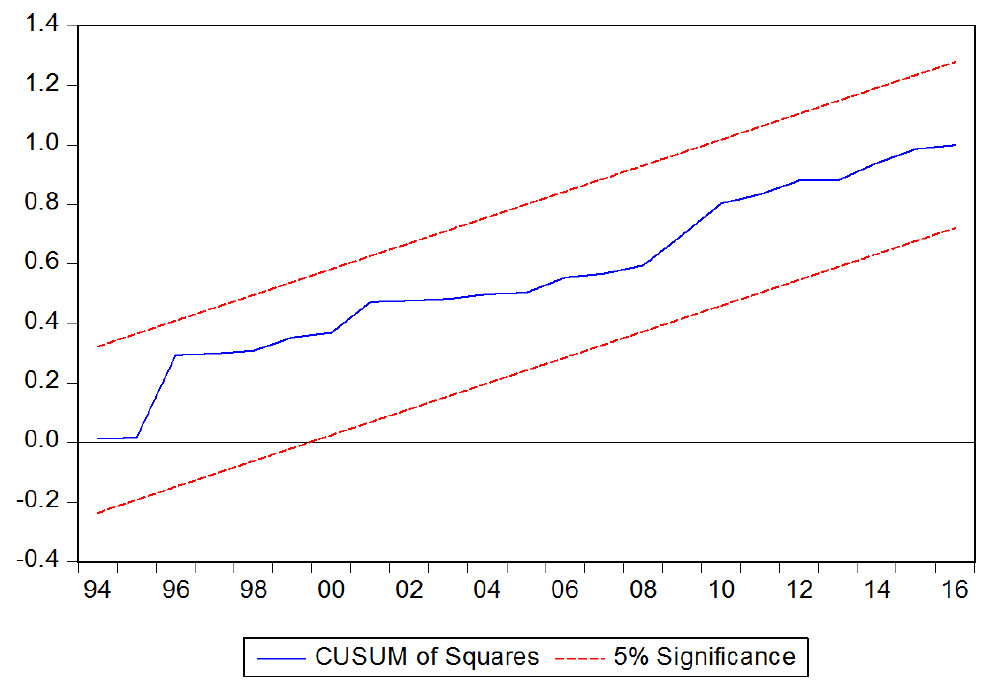
Figure 2. The plot of the cumulative sum of squares of recursive residuals.